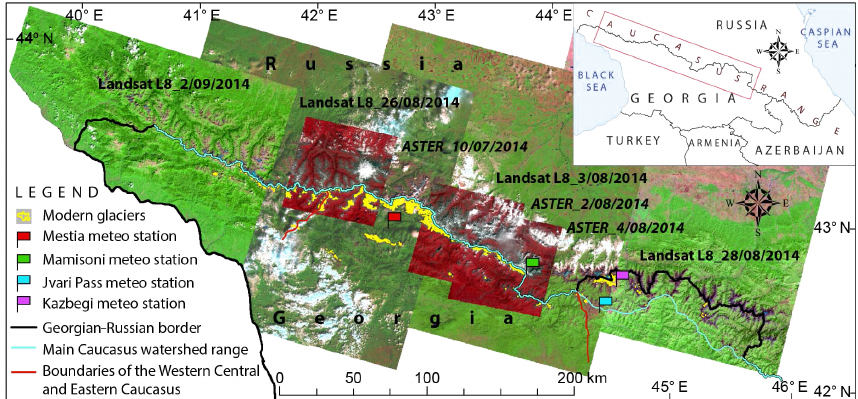
Figure 1. Georgian Caucasus glacier outlines (in yellow) derived from Landsat and ASTER imagery, and Georgia’s mountain meteorological station